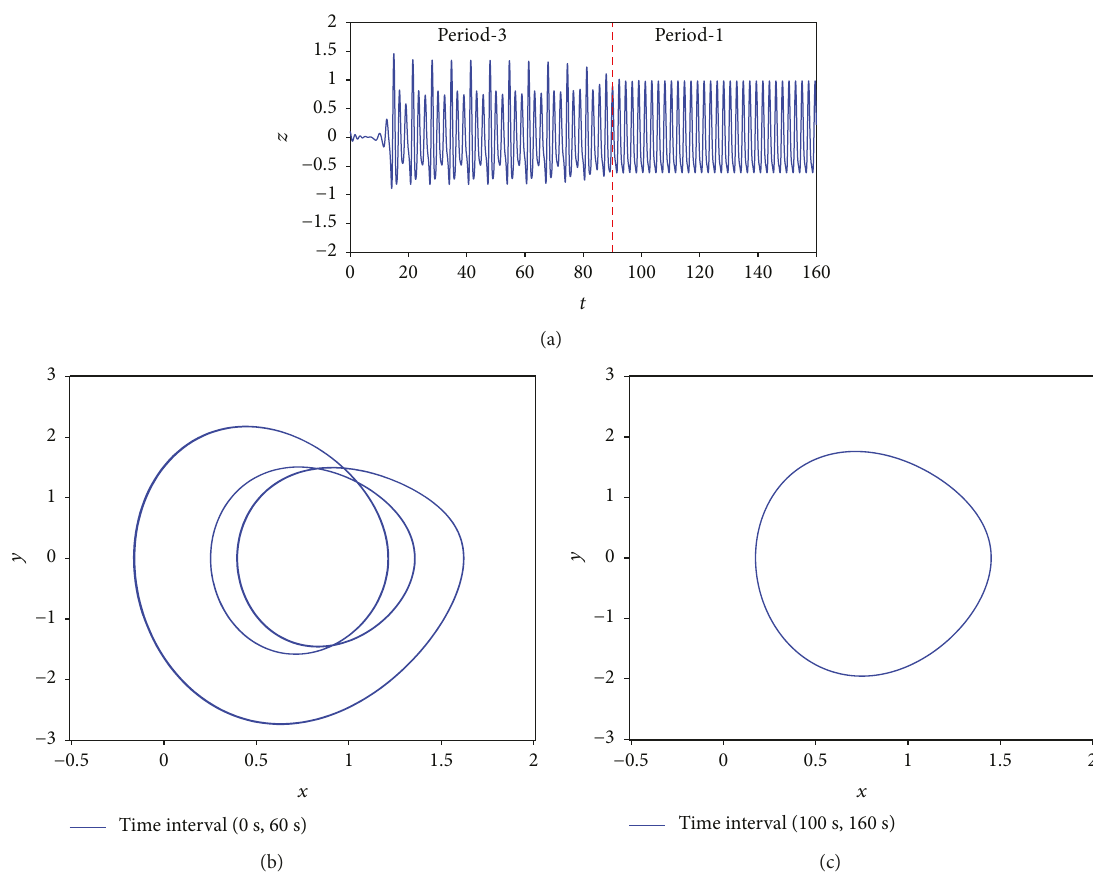
Figure 10: (a) Time-domain waveform of variable z in the region of (0 s, 160 s); (b) the phase portrait in time interval of (0 s, 60s); (c) the phase portrait in time interval of (100s, 160